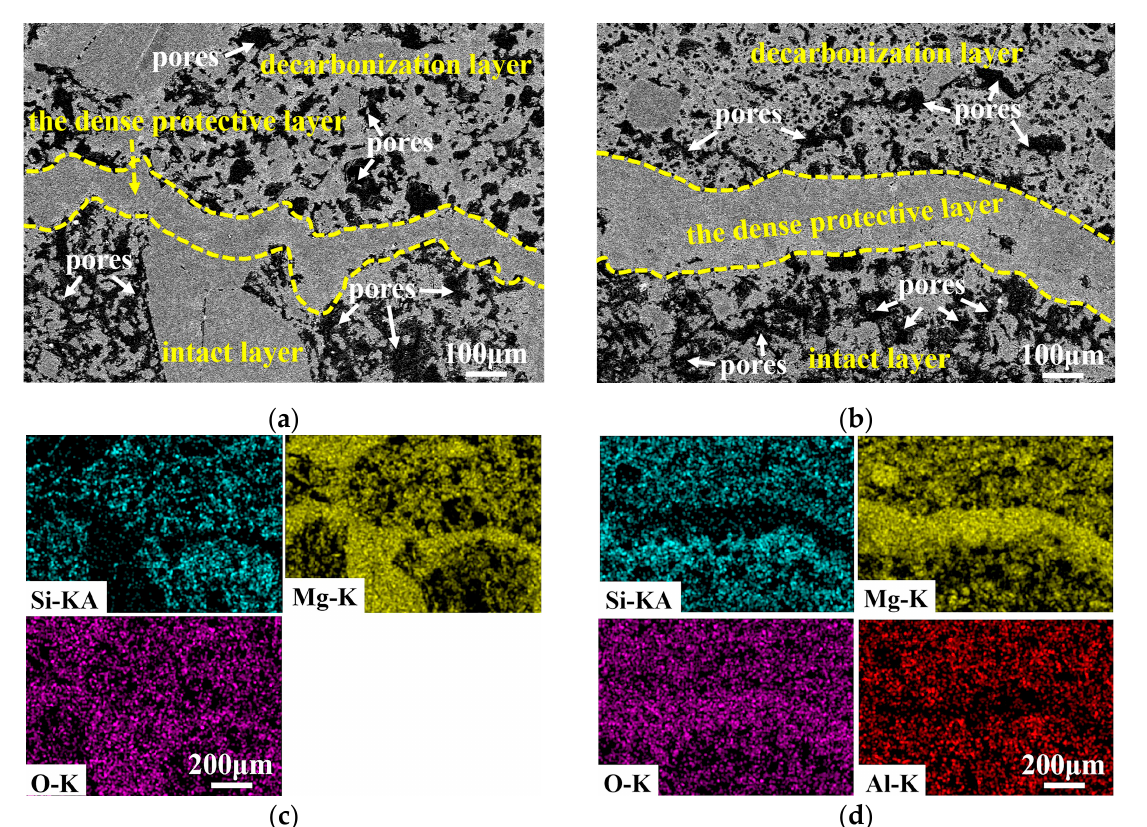
Figure 6. The transition region and the corresponding element distribution of sample ASM0 ( a , c ) and ASM5 ( b , d ) after the oxidation.